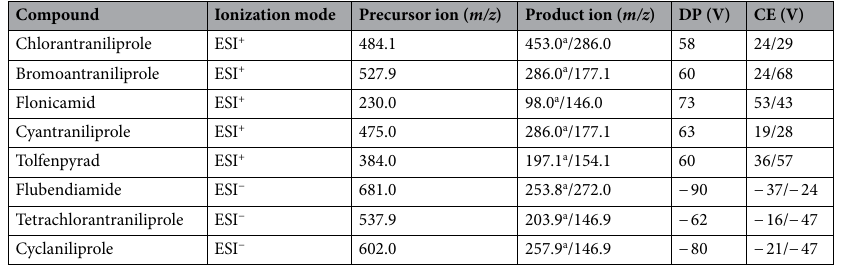
Table 1. UHPLC–MS/MS parameters for detection of the eight amide pesticides. a Quantitative